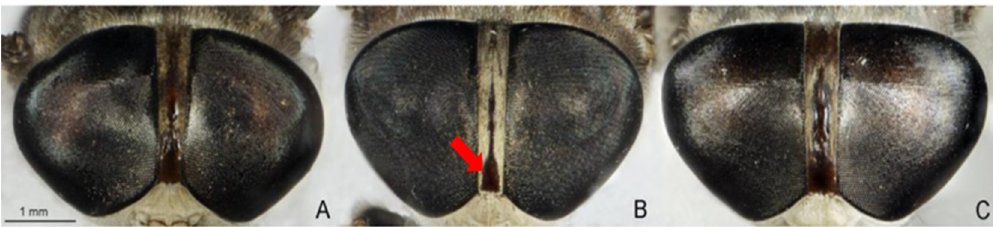
Figure 2. Morphological characteristics of basal callus used to distinguish species of Tabanus megalops ( A ), T. rubidus ( B ), and T. striatus ( C ). Tabanus rubidus is distinguished from T. megalops and T. striatus by the basal callus, which is more triangular than rectangular (arrow).